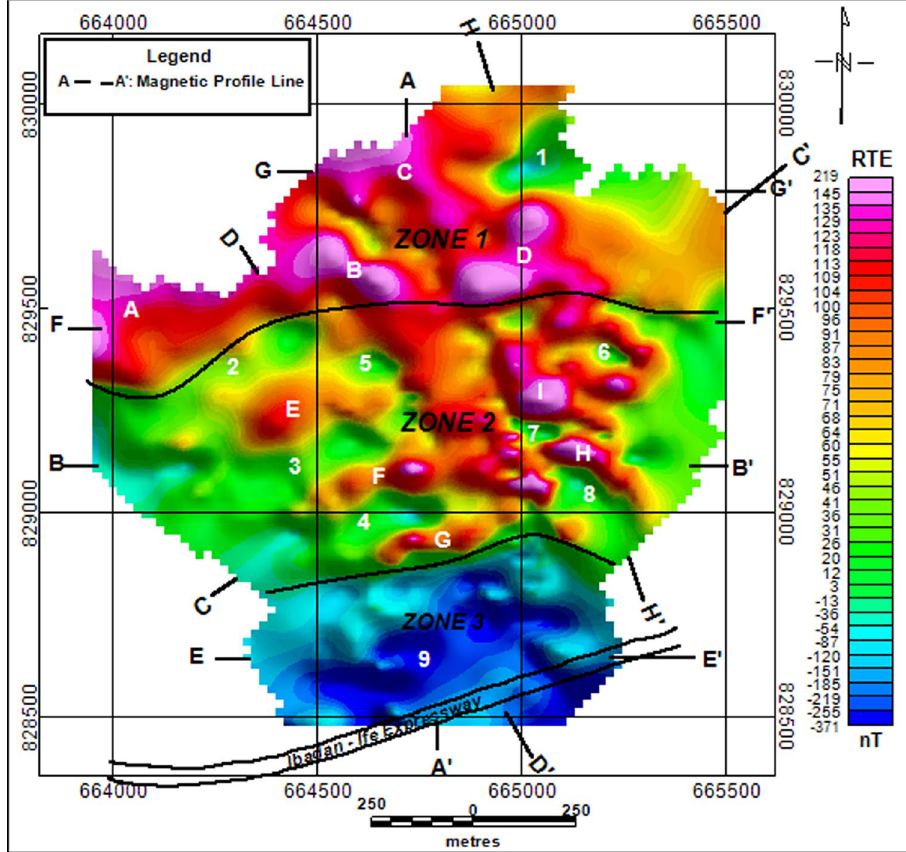
Fig. 5 Reduced to the magnetic equator (RTE) map of the study